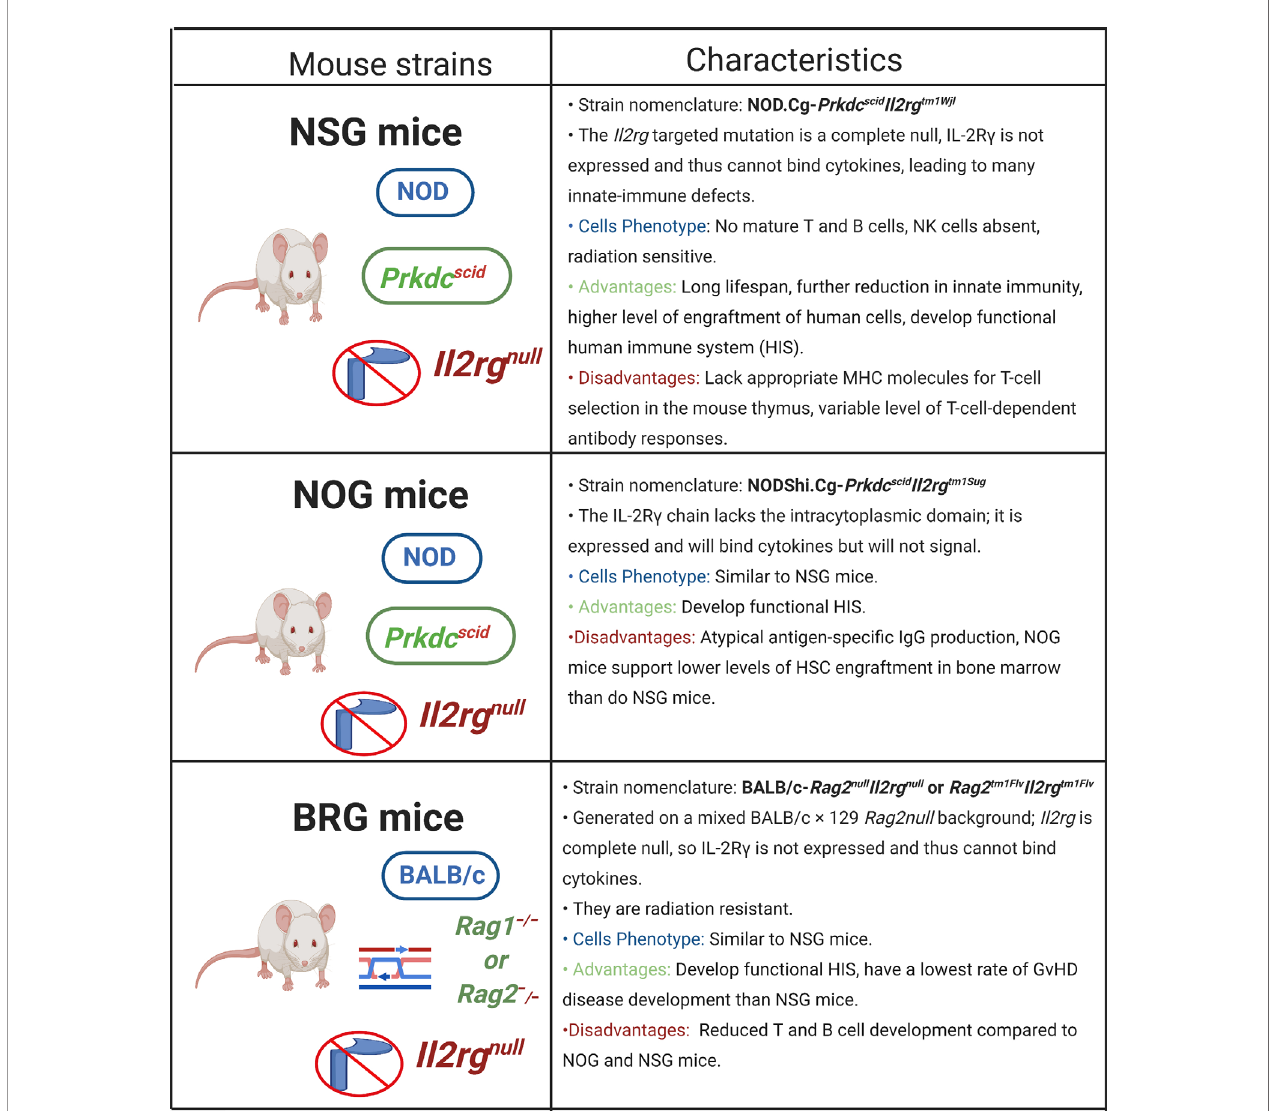
FIGURE 2 | Immunode fi cient mice strains prone to humanization. Several genetic modi fi cations have enabled that immunode fi cient host mice be capable of engrafting human cells or tissues without immediate xenogeneic rejection and allow a stable reconstitution of human cells. These immunode fi cient mice include NSG mice, NOG mice, and BRG mice, each one with its own advantages and disadvantages summarized in the Figure. il2rg , interleukin-2 receptor subunit gamma; MHC, major histocompatibility complex; NOD, non-obese diabetic. Created with